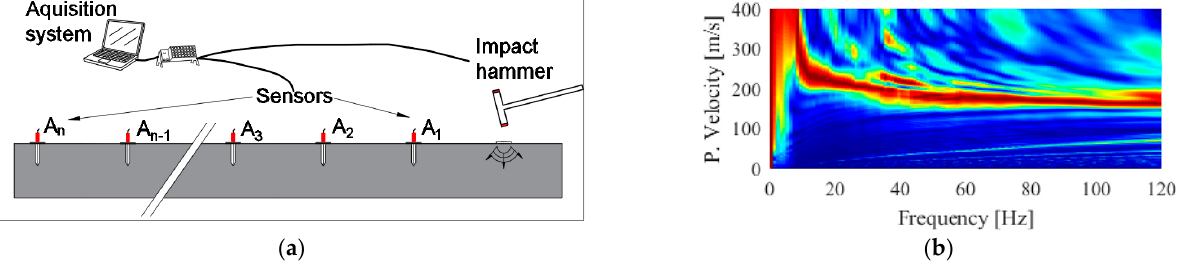
Figure 6. Dynamic characterization of the soil: ( a ) setup for the experimental activities; ( b ) experi- mental P-SV dispersion